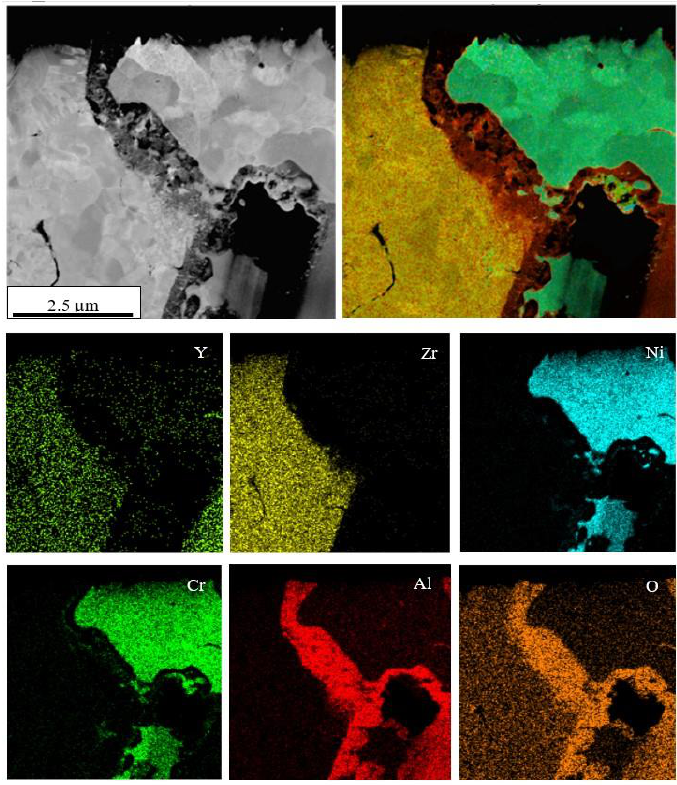
Figure 9. Cross-sectional microstructure and the corresponding EDS mapping of sample, A100h.